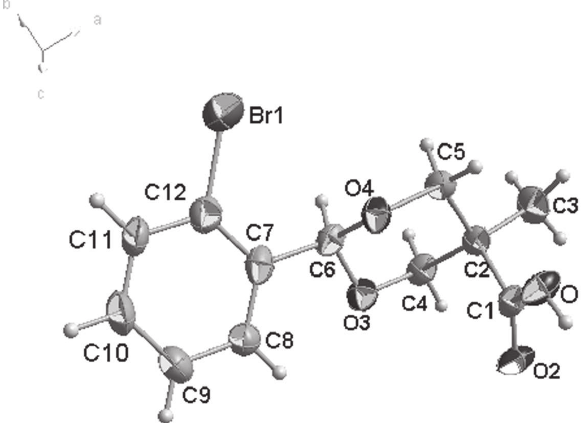
Table 1: Data collection and